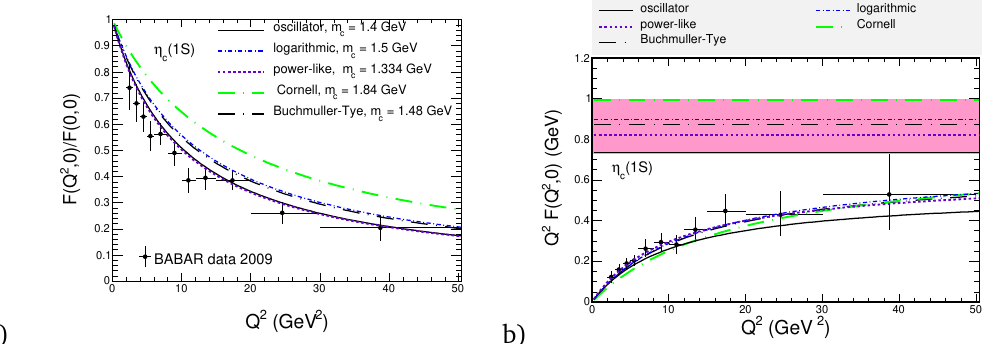
. In panel a) we show the transition c